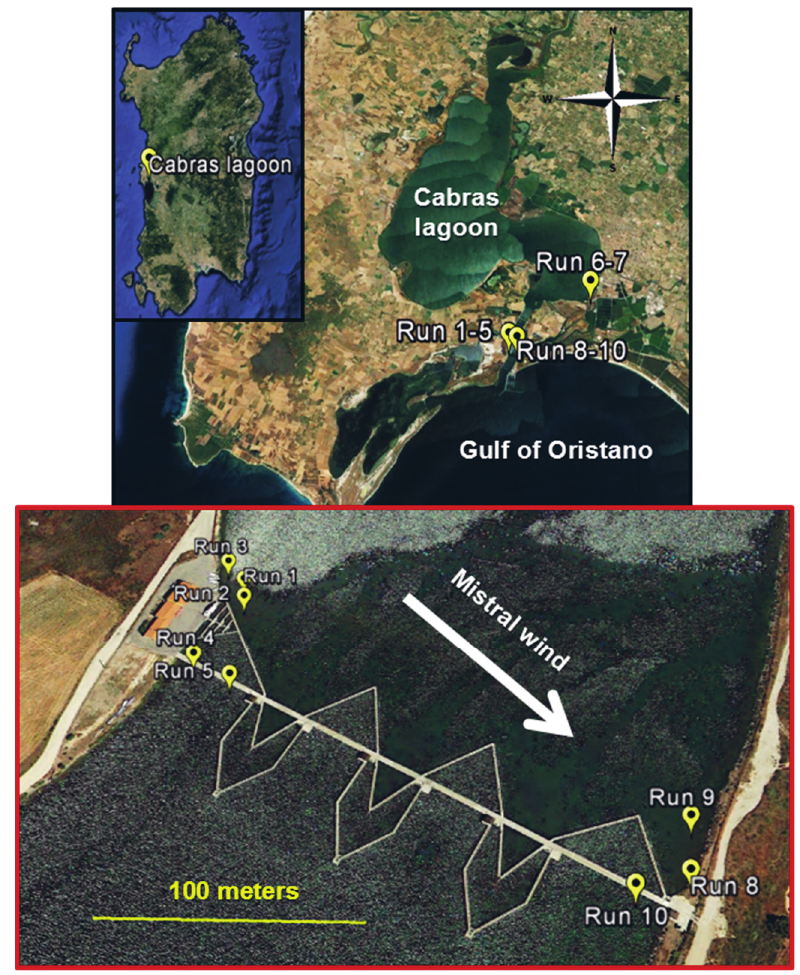
Figure 2. Station locations and dominant wind regime (modified from Google